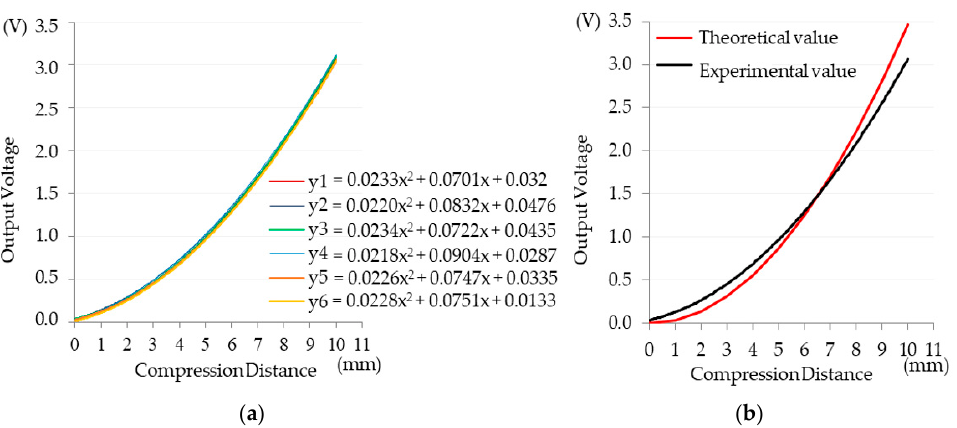
Figure 10. ( a ) Result analysis for Experiment A and ( b ) comparison between theoretical and experimental values in Experiment A.